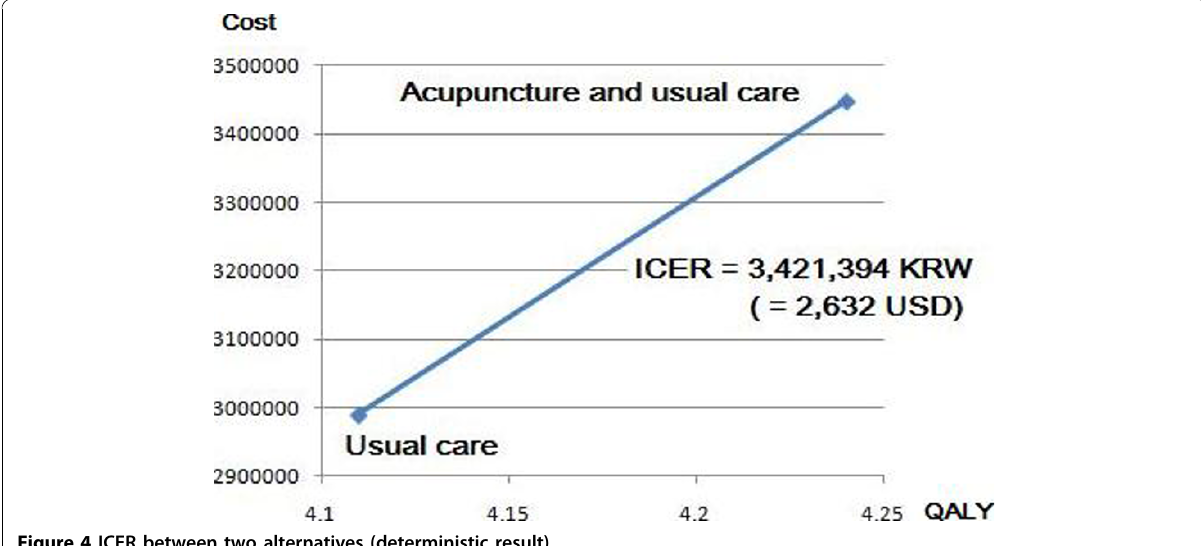
Figure 4 ICER between two alternatives (deterministic result)